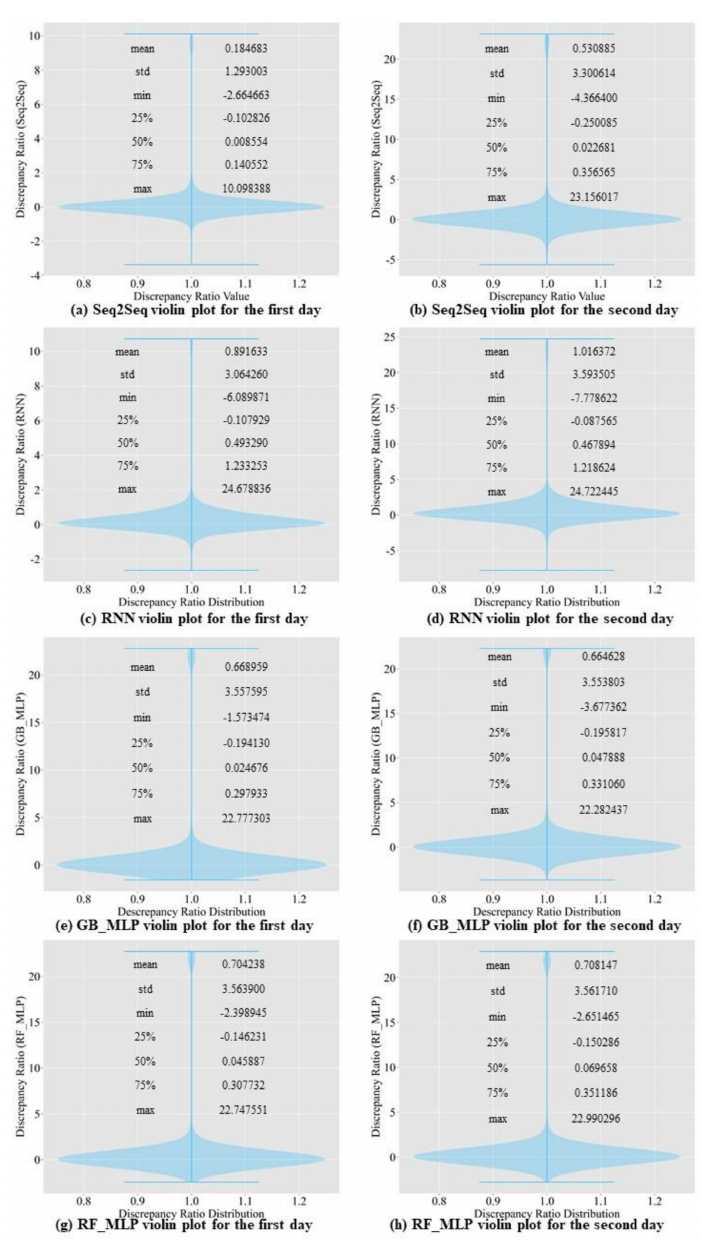
Figure 13. Violin plot for the discrepancy ratio for the proposed model and baseline